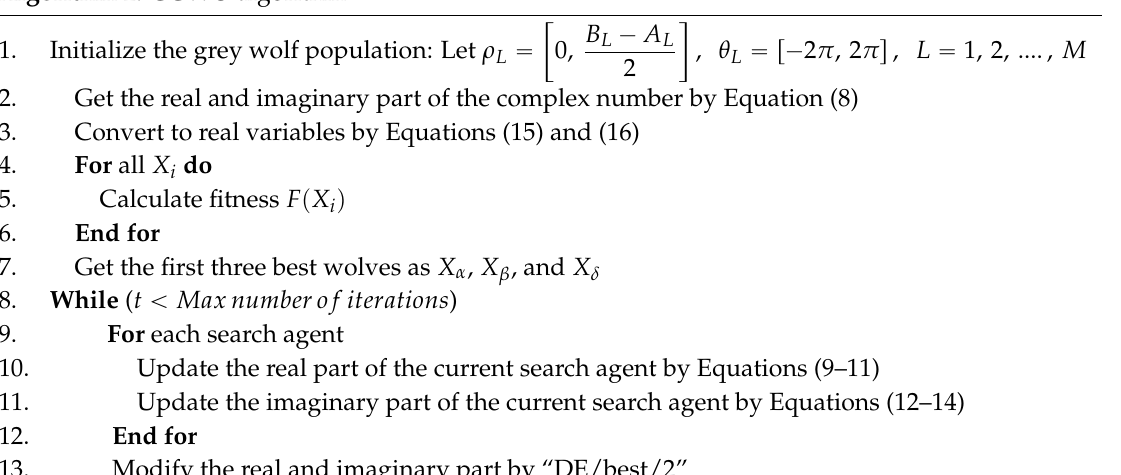
Algorithm 2. CGWO